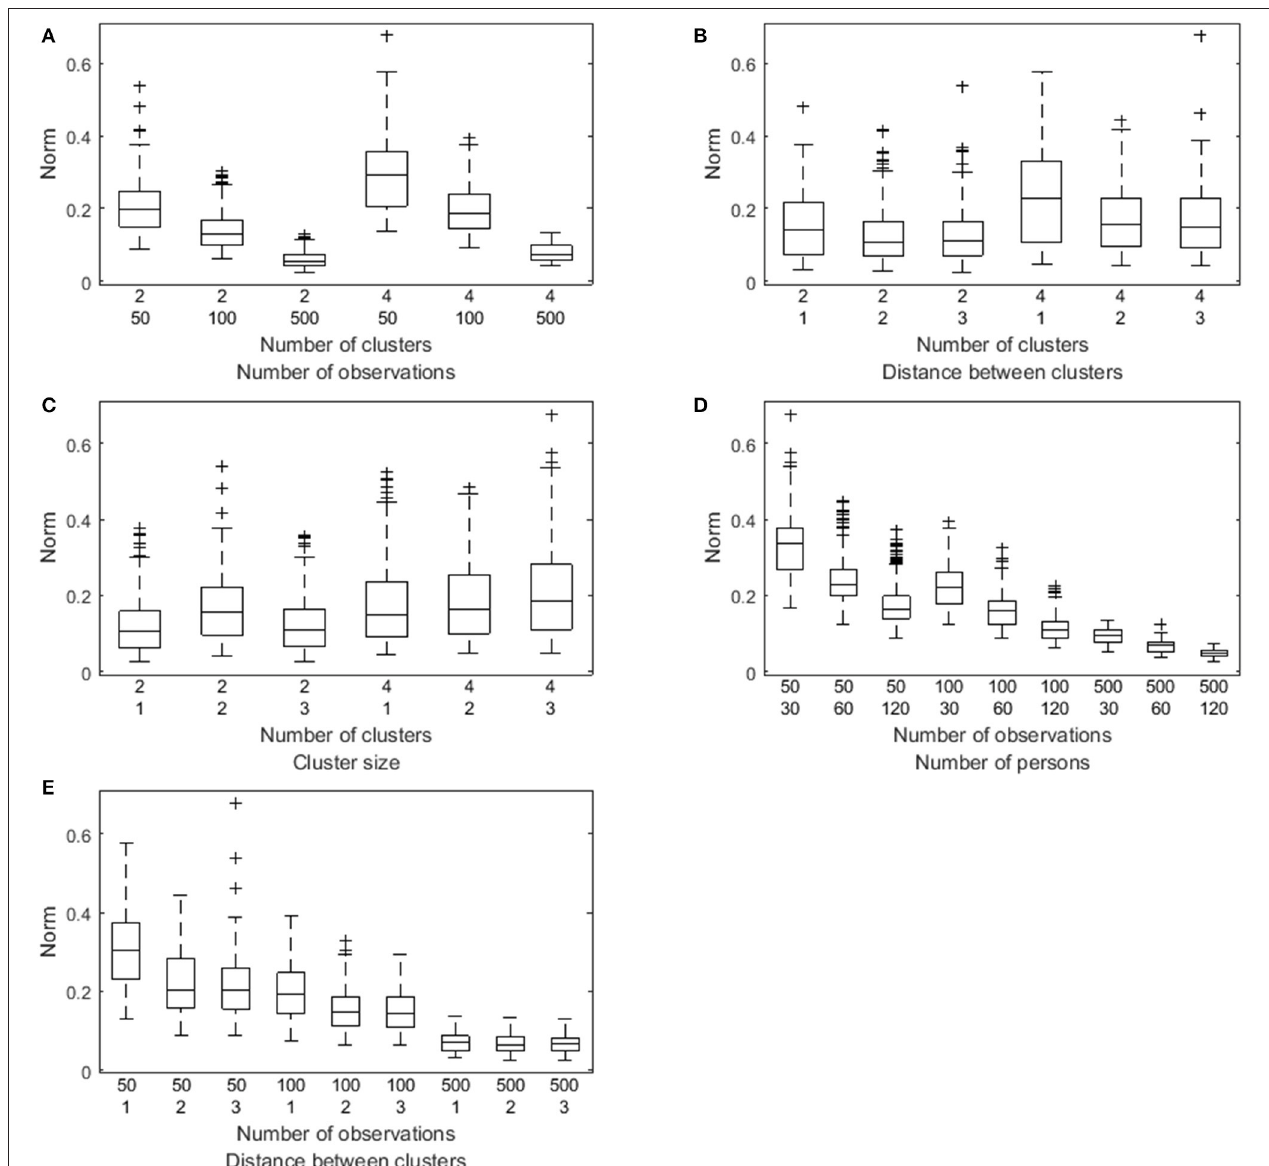
FIGURE 5 | Box plot of the Euclidian distance (denoted Norm) between the true and the estimated VAR(1) coefficients as a function of both the number of clusters and the number of observations (A), of both the number of clusters and the distance between the clusters (B), of both the number of clusters and the relative cluster sizes (C), of both the number of time points per person and the number of persons (D), and of both the number of observations per person and the distance between the clusters